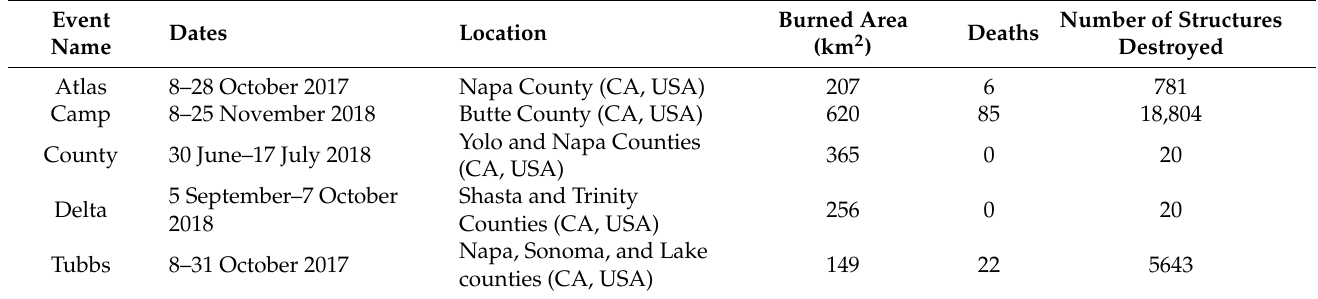
Table 2. Wildfires used for validation of the proposed